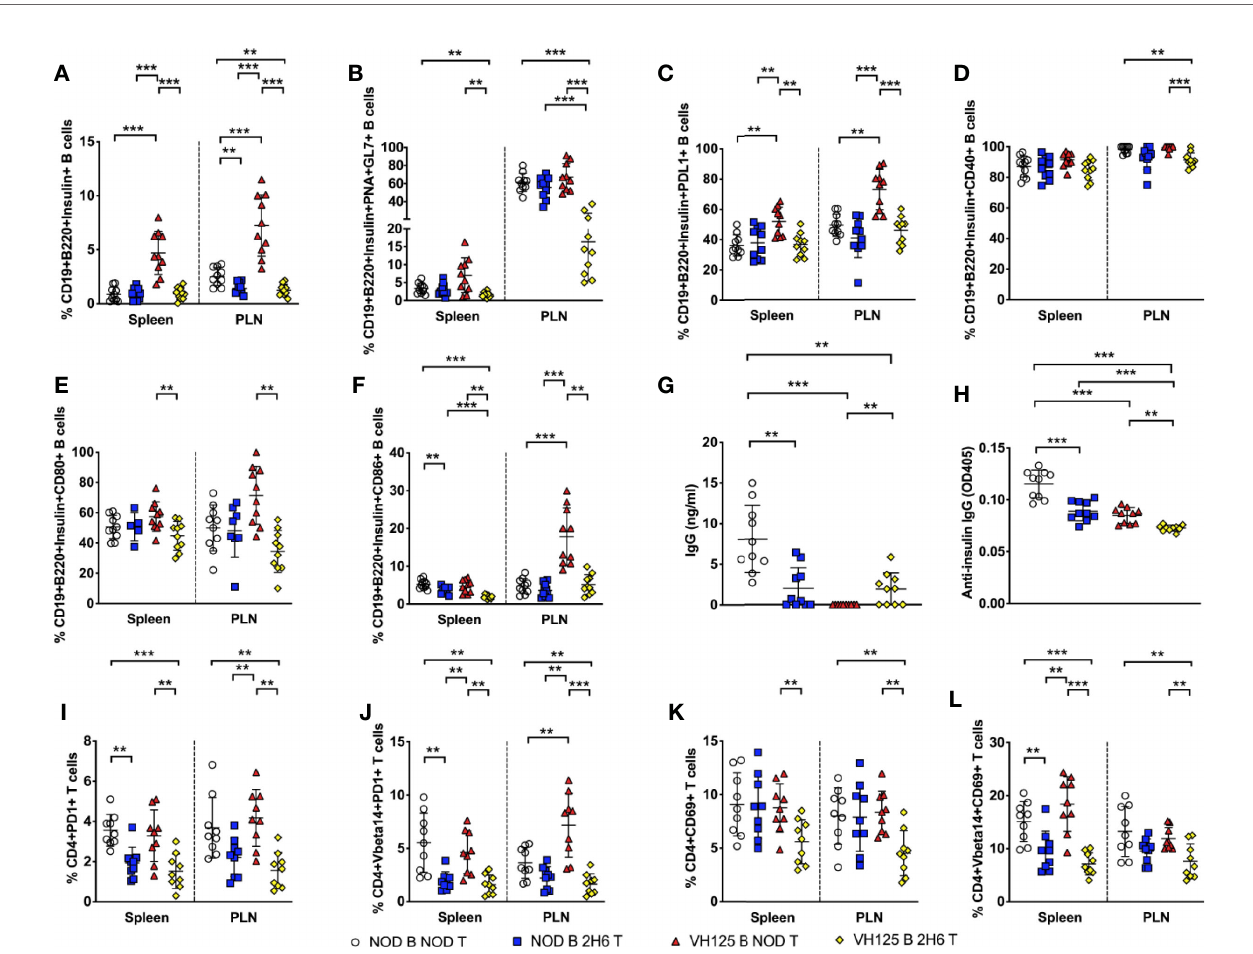
FIGURE 6 | 2H6 T cells reduce VH125 B cells interactions in vivoinRag-de fi cient NODmice. 4-week-old Rag-/-NODmice were adoptively transferred i.v. with 3 × 10 6 CD4+ T cells together with B cells ina 1:1 ratio, using 8-week-old donor NOD, 2H6 NOD and VH125 NODmice. 4 weekspost-transfer, splenocytes and cells from the pancreas draining lymph nodes (PLN) were harvested from 8-week-old mice andstained using antibodies for fl ow cytometry. (A) % of Insulin-reactive B cells gated from CD19+B220+TCR b - live singlecells. % Insulin-reactive B cells expressingPNA andGL7 (B) , PDL1 (C) , CD40 (D) , CD80 (E) , andCD86 (F) , gated from (A) . Sera from the same mice were used to measure total class-switched IgG (G) andtotalinsulin-reactiveIgG (H) byELISA. (I) % CD4+PD1+ T cells was gated on livesingleCD19-CD8- cells with the same gating applied to CD4+PD1+TCRVbeta14+ T cells shown in (J) . (K) % CD4+CD69+ T cells in totalCD4+ T cells (K) and TCRVbeta14+CD4+ T cells (L) . Data were generated from nineindividual mice pooled from two independent experiments. Data from leftto right: NODB and NODT, NOD B and2H6 T, VH125 B andNOD T, VH125 B,and 2H6 T areshownin this order ineach plot. Data from NODB and NODT cellrecipient Rag-/-NODmiceare shownas a non-transgenicmouse comparison. Data were assessedfor signi fi cance using multipleT tests and FDR correction. **P < 0.001, ***P <